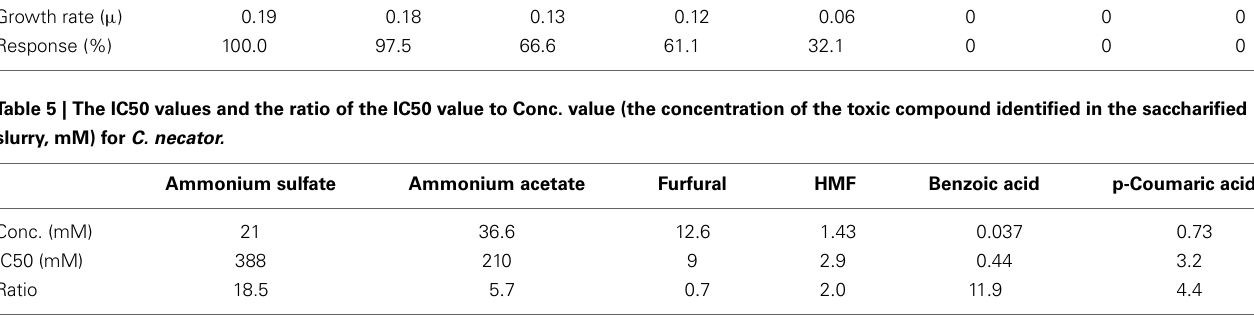
Table 4 | The growth rates and responses of C. necator to various furfural concentrations (mM) supplemented in the minimal medium. Conc. (mM)